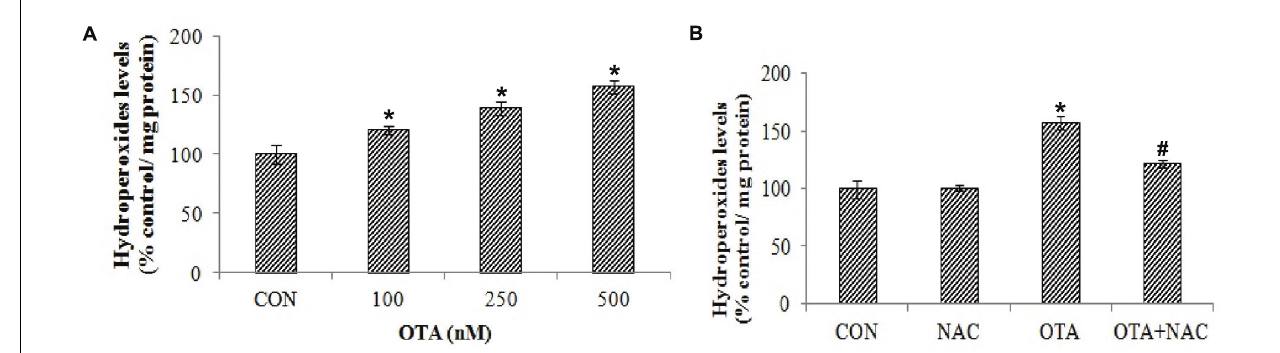
FIGURE 3 | Effect of OTA on hydroperoxide levels in Neuro-2a and its scavenging by NAC. (A) Neuro-2a cells were treated with various concentrations of OTA (100–500 nM) for 24 h. Hydroperoxide levels were quantified (B) . Neuro-2a cells were pretreated with NAC (1 mM) for 24 h followed by OTA (500 nM) treatment for 24 h and amount of hydroperoxide produced was assessed. The data represented as mean ± SEM of three independent experiments. ∗ p < 0.05 versus respective control group and # p < 0.05 versus respective OTA treated group.